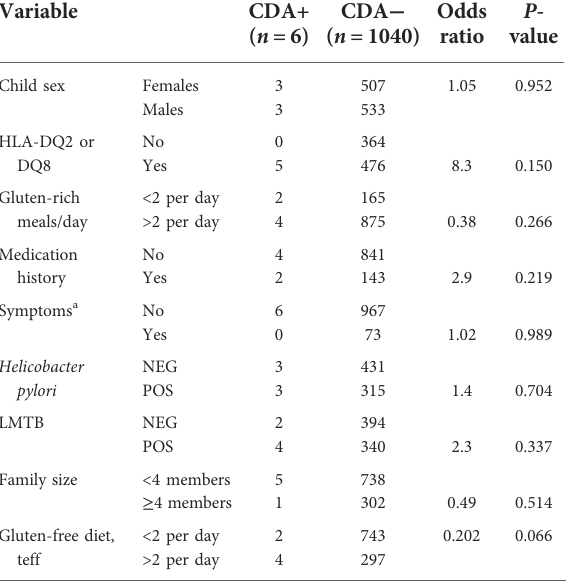
TABLE 1 Observed factors in children with and without